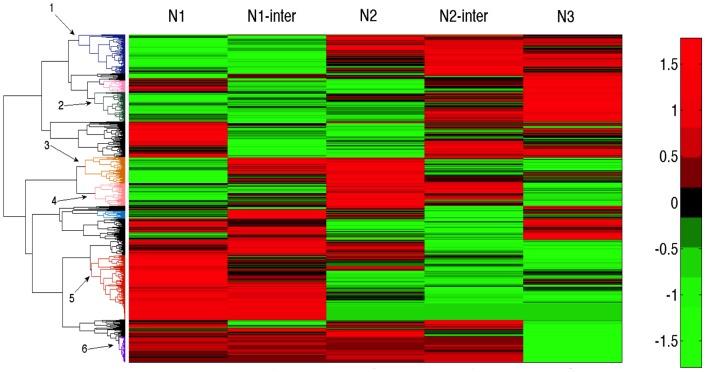
Clustering of all human proteome according to their segmental tAI values for the N′-terminal.A total of 18,434 proteins are included in the analysis and clustered by the calculated tAI for 5 consecutive overlapping segments at the N′-terminal region of the proteins. Unsupervised clustering resulted in several dominating clusters that are numbered 1–6. Red and green colors mark the low and high segmental tAI values, respectively (according to the scale). For details on annotation enrichment for each cluster, see Table S4.